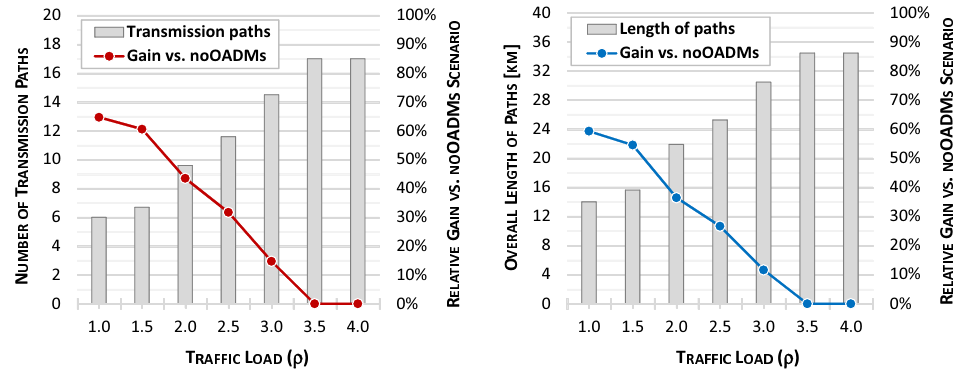
Figure 5. The number of transmission paths ( left ) and overall length of paths ( right ) in a function of traffic load ( ρ ) in WRO17; relative gain versus the network without OADMs is shown as lines.